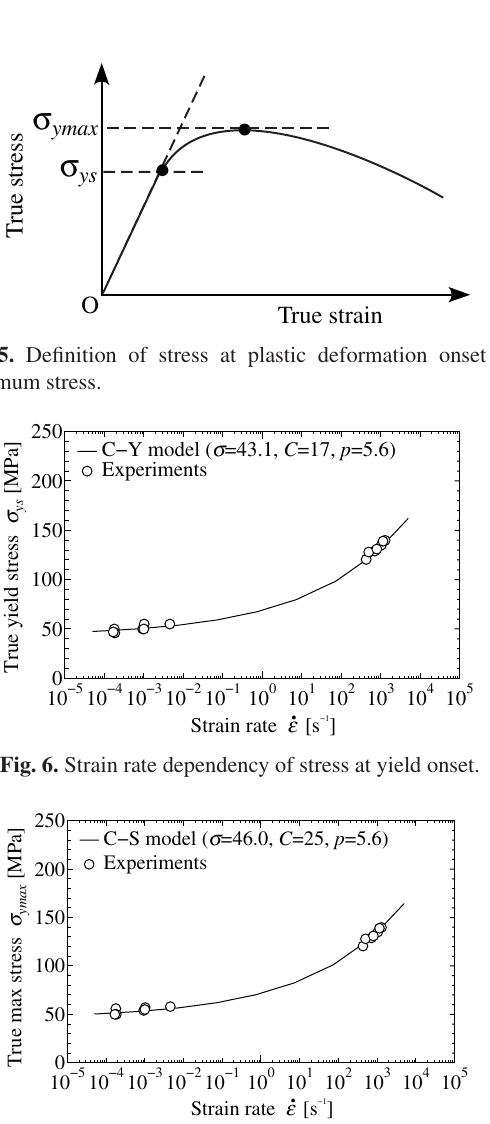
Fig. 7. Strain rate dependency of maximum yield stress.